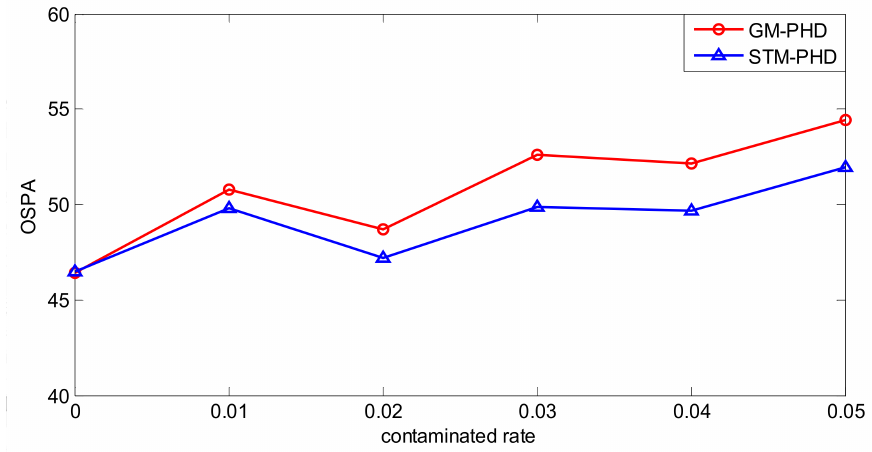
Figure 12. Comparison of OSPA distance of two filters with different contamination